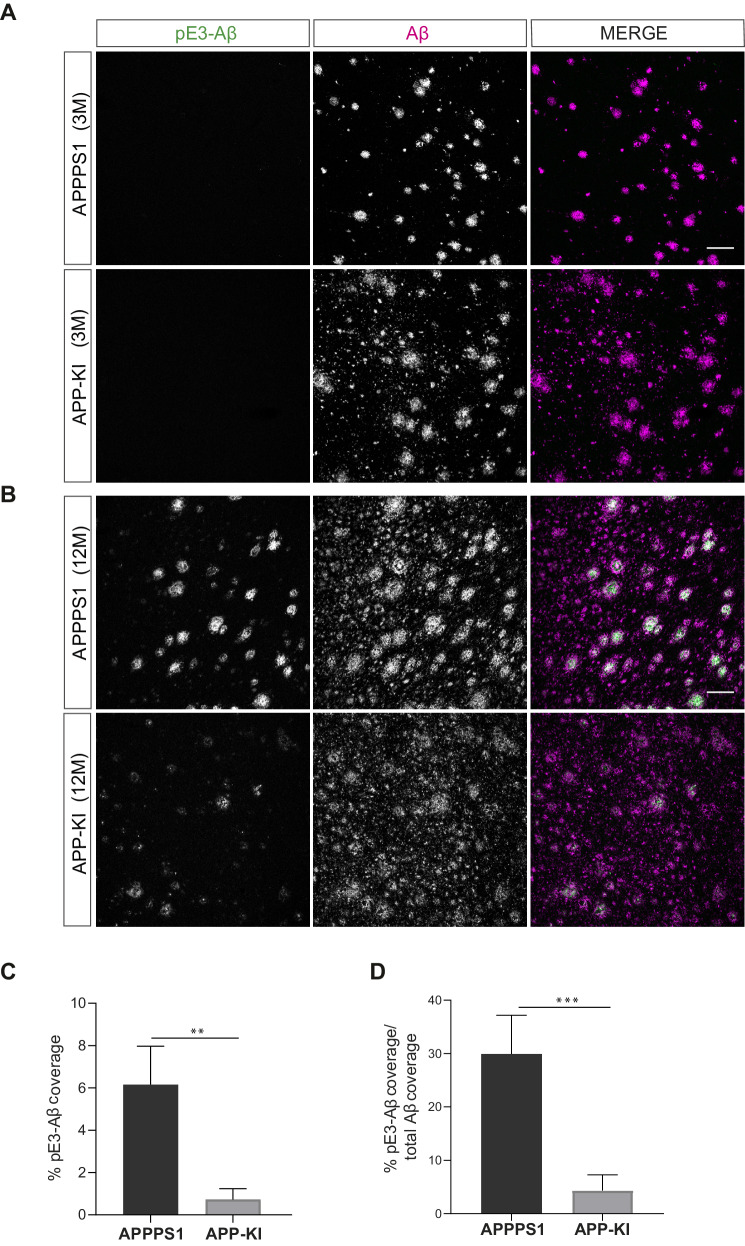
pE3-Aβ does not correlate with early microglial changes in 3 month old APPPS1 mice.Immunohistochemical analysis of pE3-Aβ (green) compared to the total Aβ area (magenta) in 3 (A) and 12 (B) month old APPPS1 and APP-KI mice. Scale bar: 100 µm. Quantification of pE3-Aβ coverage in 12 month old APPPS1 and APP-KI mice. Values are expressed as percentages of area covered by pE3-Aβ (C) or as percentages of area covered by pE3-Aβ from the total Aβ coverage (D). Values in (C) and (D) are expressed as the mean ± SD from N = 4 mice (**p<0.01, ***p<0.001, unpaired two-tailed Student’s T-test).